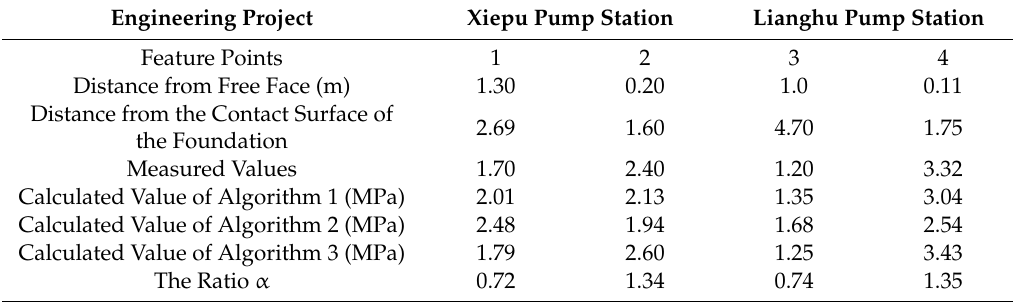
Figure 11. Relative error of three algorithms based on measured values. Table 3. Maximum values of the first principal stress at feature points of pouring blocks in different projects.